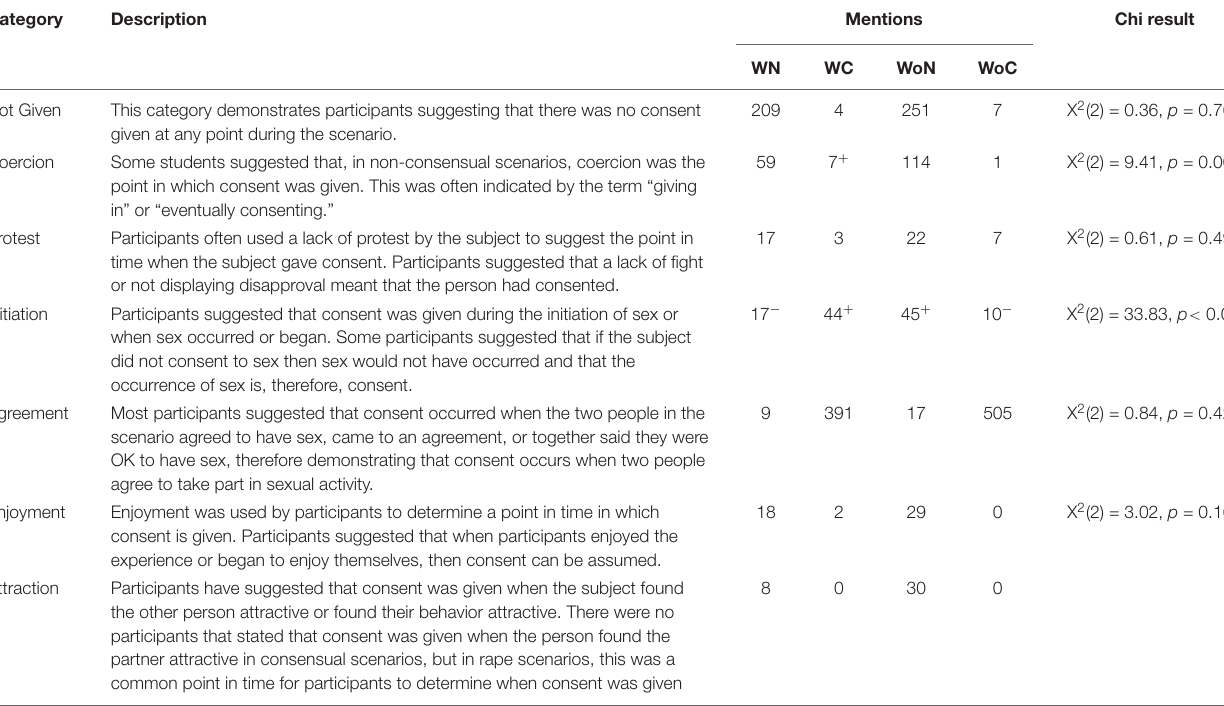
TABLE 2 | Summary content analysis (full analysis presented in Supplementary Table S2 ) for the question “Please explain at which point in the scenario you think consent was